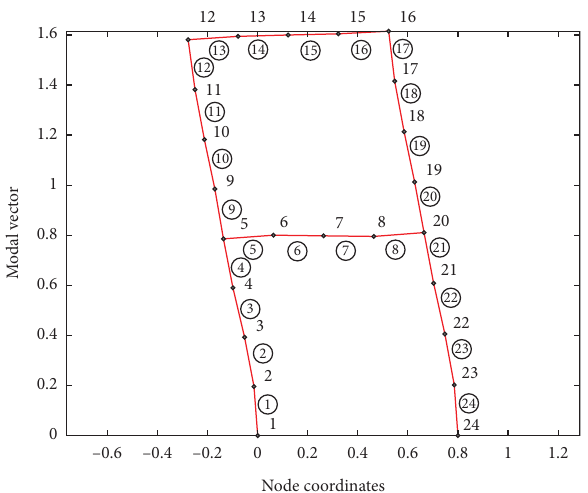
Figure 7: The measured first eigenvector of the frame structure.